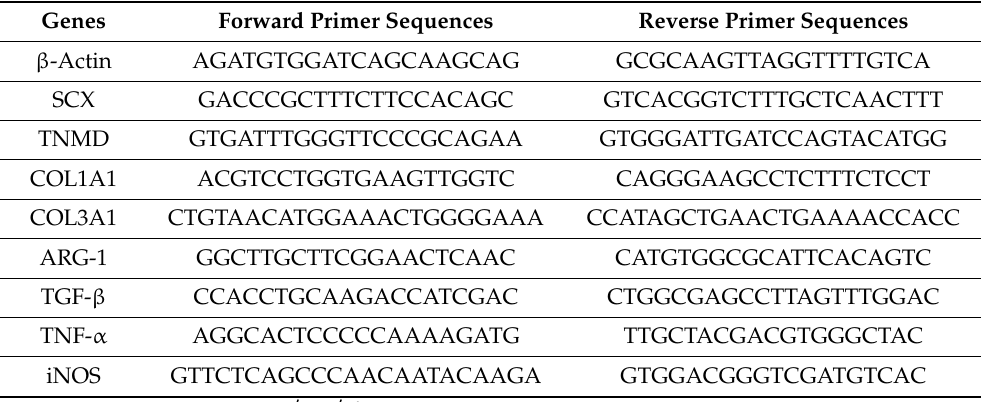
Table 1. Reverse transcription–polymerase chain reaction primer sequences.